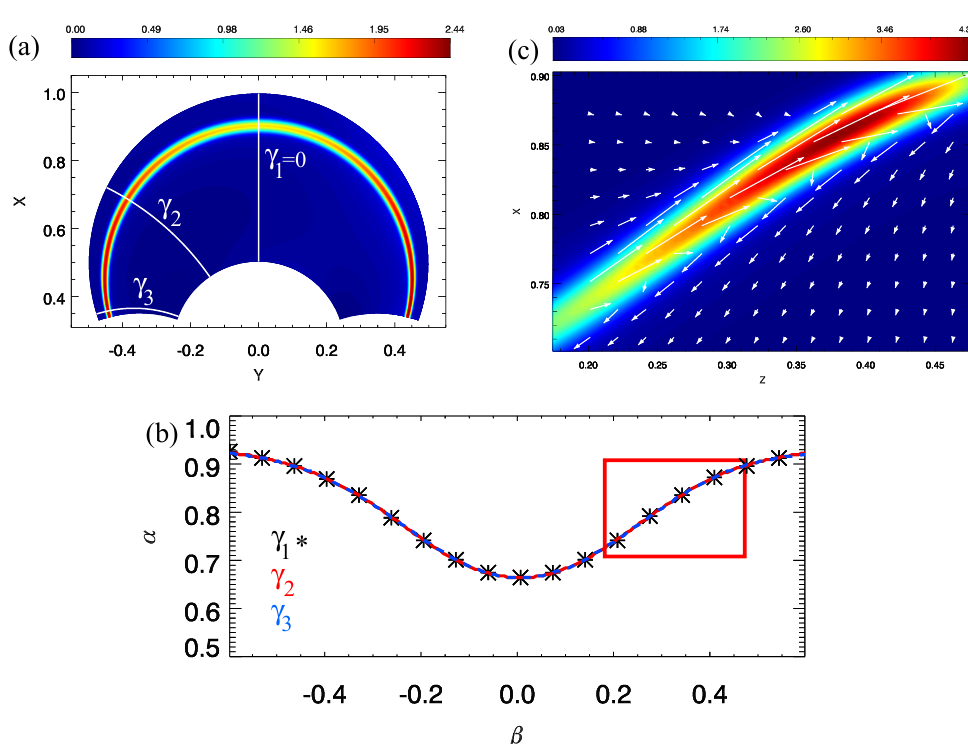
Figure 3. ( a ) Time-averaged energy density in the plane β = z = 0.5. The intersection with three surfaces of the field-aligned coordinate ( γ 1 = 0, γ = γ 2 and γ = γ 3 ) are also shown. ( b ) The location of where the energy density maximizes α W ( β , γ ) for the three surfaces γ = γ 1 (black symbols), γ 2 (red line) and γ 3 (blue dashed line). ( c ) A close-up view of the energy density on the field lines carrying a 3D Alfvén resonance (identified by the red rectangle in ( b )) plotted in the γ = γ 1 = 0 plane (equivalent to the y = 0 plane) with velocity vectors overplotted. See text for